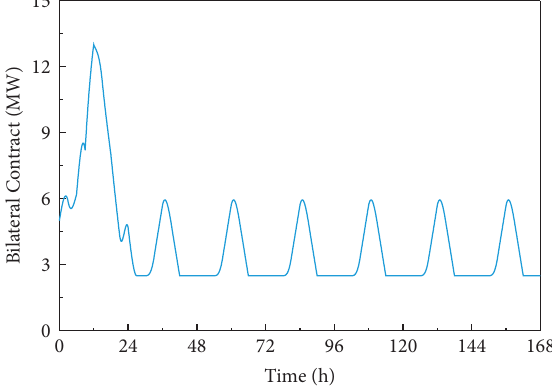
Figure 3: Bilateral electricity contract curve.